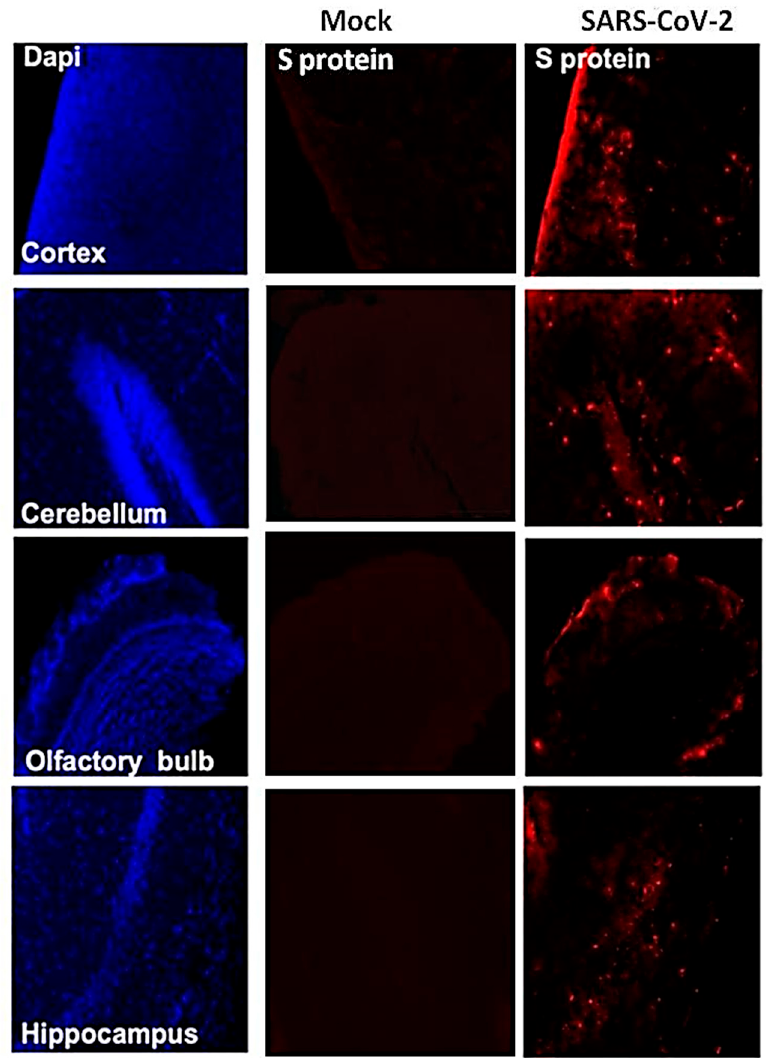
Figure 5. Detection of SARS-CoV-2-infected cells in the brains of K18-hACE2 transgenic mice. Brain sections (day 6 after infection) were stained for SARS-CoV-2 spike protein. Representative immunostaining images showing the presence of SARS-CoV-2 spike protein ( red ) in the cortex, cerebellum, hippocampus and olfactory bulb of infected mice. Nuclei were stained with 4 ′ ,6-diamidino-2-phenylindole (DAPI) ( blue ). The photomicrographs shown are representative of the images obtained from five animals. Bars, 20 μ m.